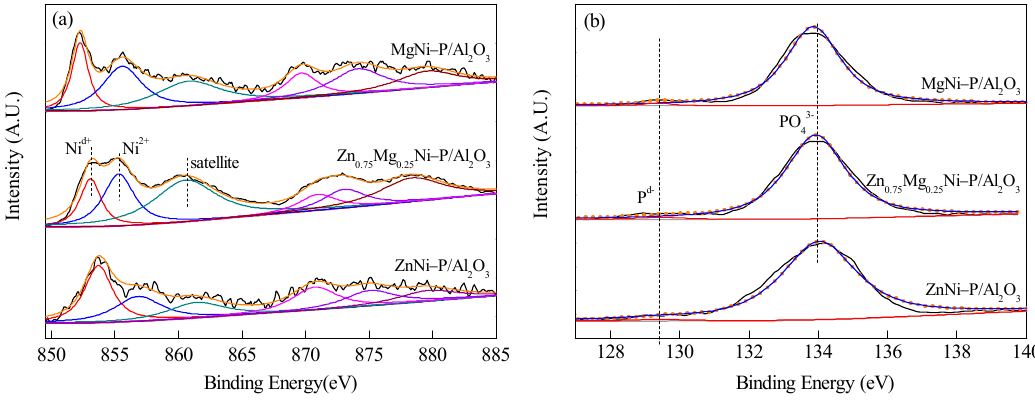
Figure 3. N 2 adsorption ‐ desorption isotherms ( a ) and corresponding pore size distributions ( b ) for